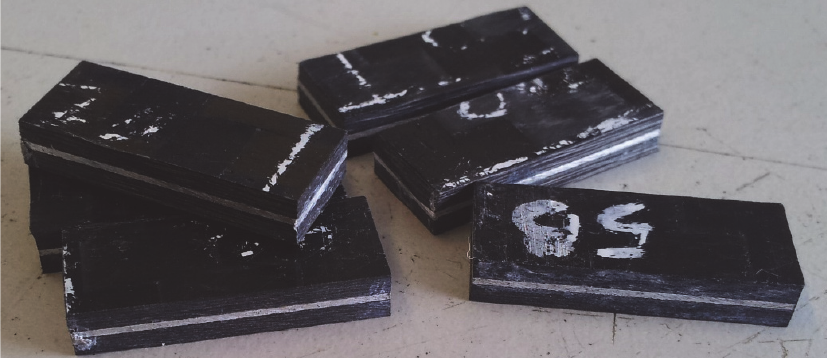
Figure 1: Short beam specimens with a single aluminium sheet.